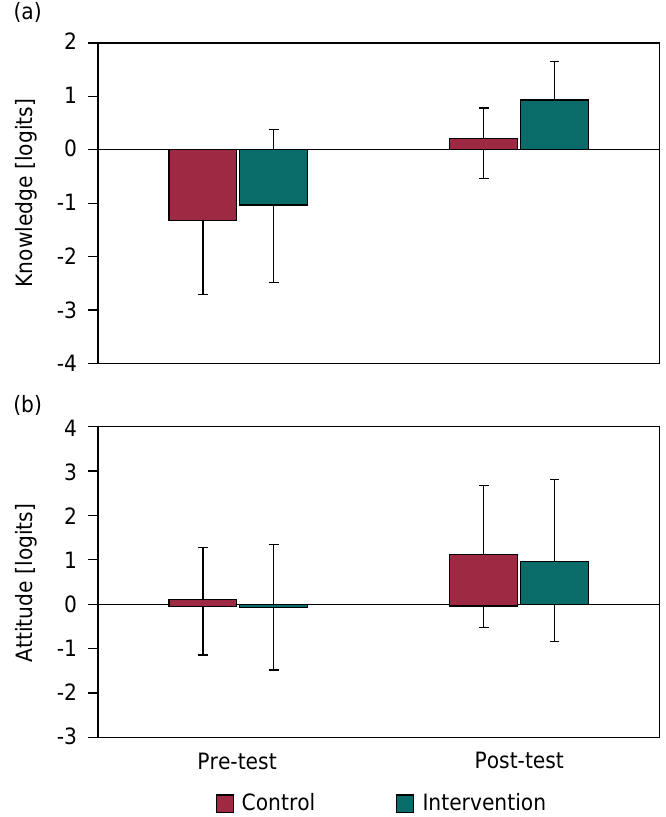
Figure 1. Quantification of the impact of laboratory and field components on (a) soil knowledge and (b) attitude toward the soil. Error bars mean standard deviation. The scores for each scale were expressed in logits. For the attitude scale, the logit stands for the natural logarithm of the positive/ negative attitude ratio. Likewise, the logit stands for the natural logarithm of the correct/incorrect response ratio for the knowledge scale. For instance, logit values are negative when correct responses are given to less than 50 % of all the questions; positive with correct responses to more than 50 % of the questions; and equal to zero when correct responses match 50 % of the